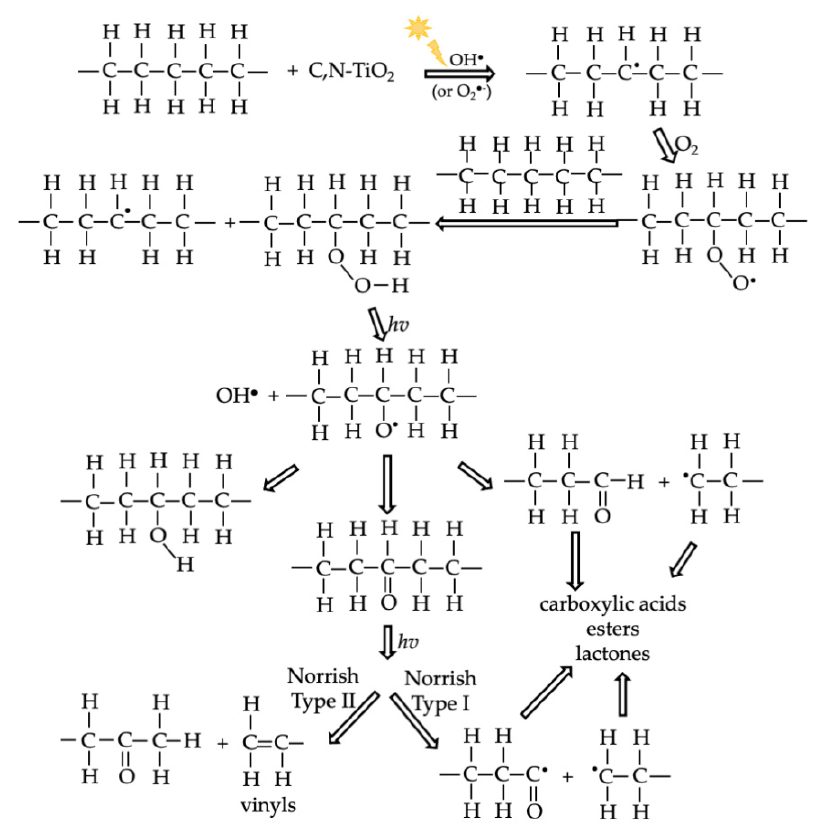
Figure 6. Visible-light photocatalytic degradation of HDPE MPs by C,N-TiO 2 in the absence and presence of Tiron as O 2 ●− scavenger.